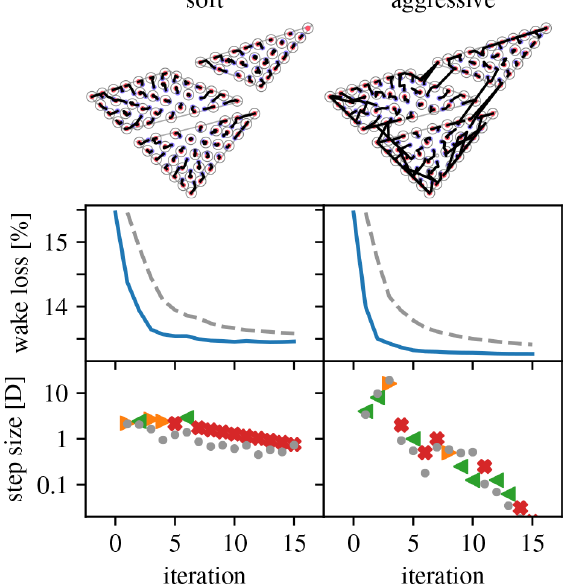
Figure 22. Overview of optimization runs for the Borssele IV wind farm layout problem, 90-turbine case. (Legend in Table 1.)